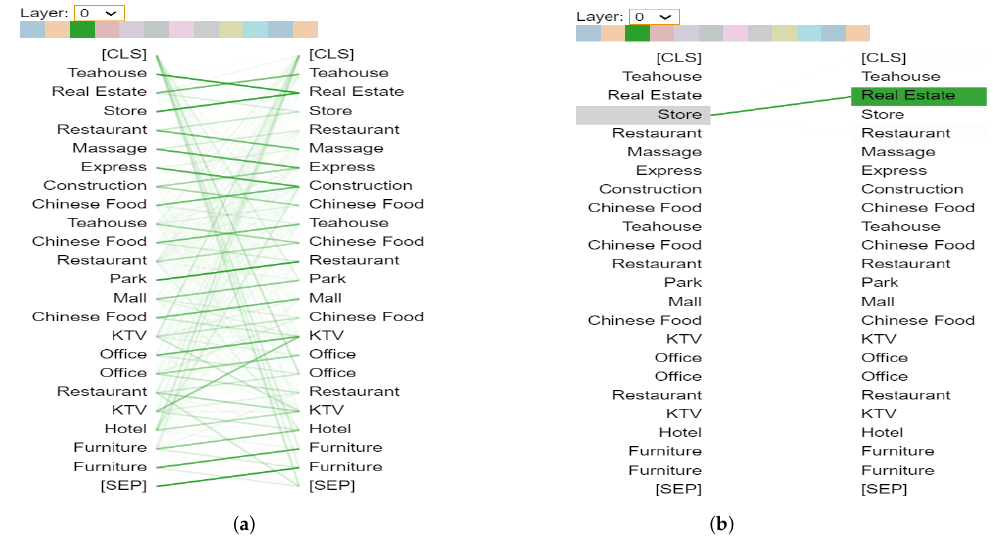
Figure 13. The pattern of attention to the previous token. In the example of Layer 0, Head 2, most tokens show apparent attention weight directed to the previous tokens. Of course, there are some exceptions, such as the token “Teahouse”, which still has close attention to the next token “Real Estate”: ( a ) attention weights for all tokens in Layer 0, Head 2; ( b ) attention weights for selected token ’Store’.